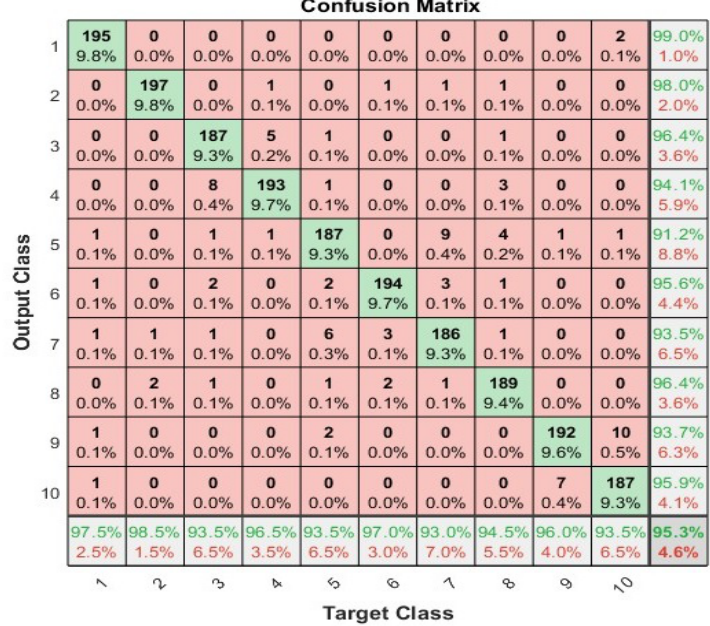
Figure 8. Confusion matrix of neural networks using activation function tan-sigmoid.